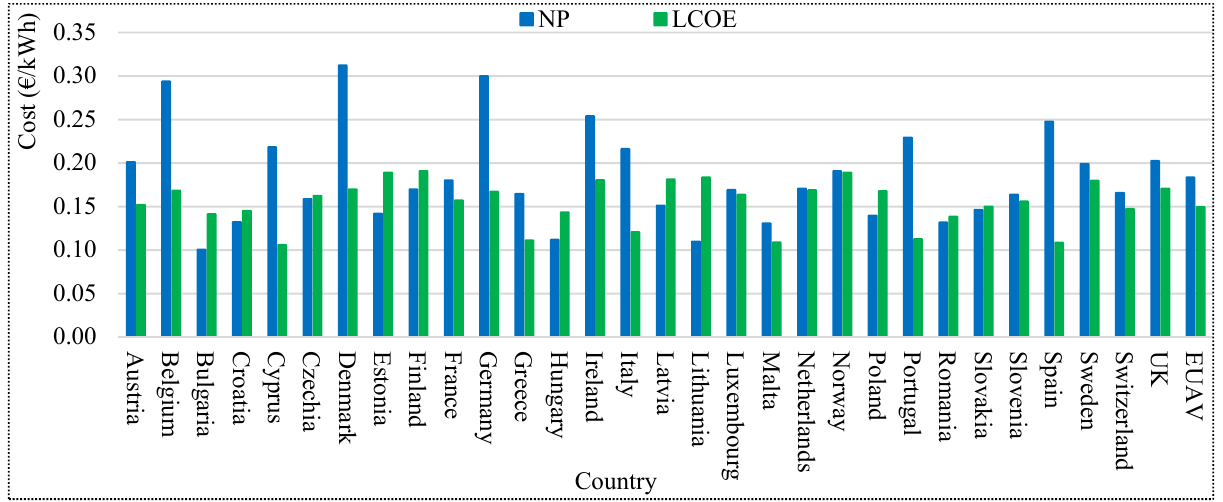
Figure 4. NP and LCOE in Scenario 1.